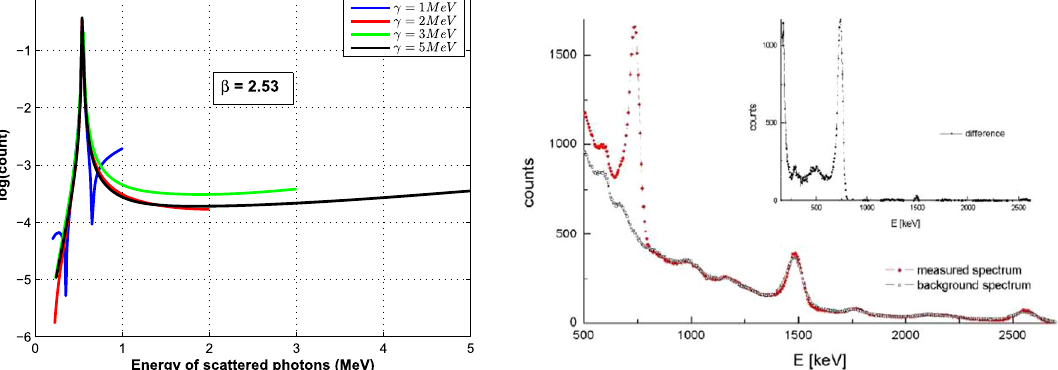
Fig. 2 Gamma-ray and heavy electron cross-section: a peak under 1 MeV for various energies of an incident photon compatible with experimental data (left). The effects of gamma radiation in the region below 1 MeV from the result of the Piantelli group [50]